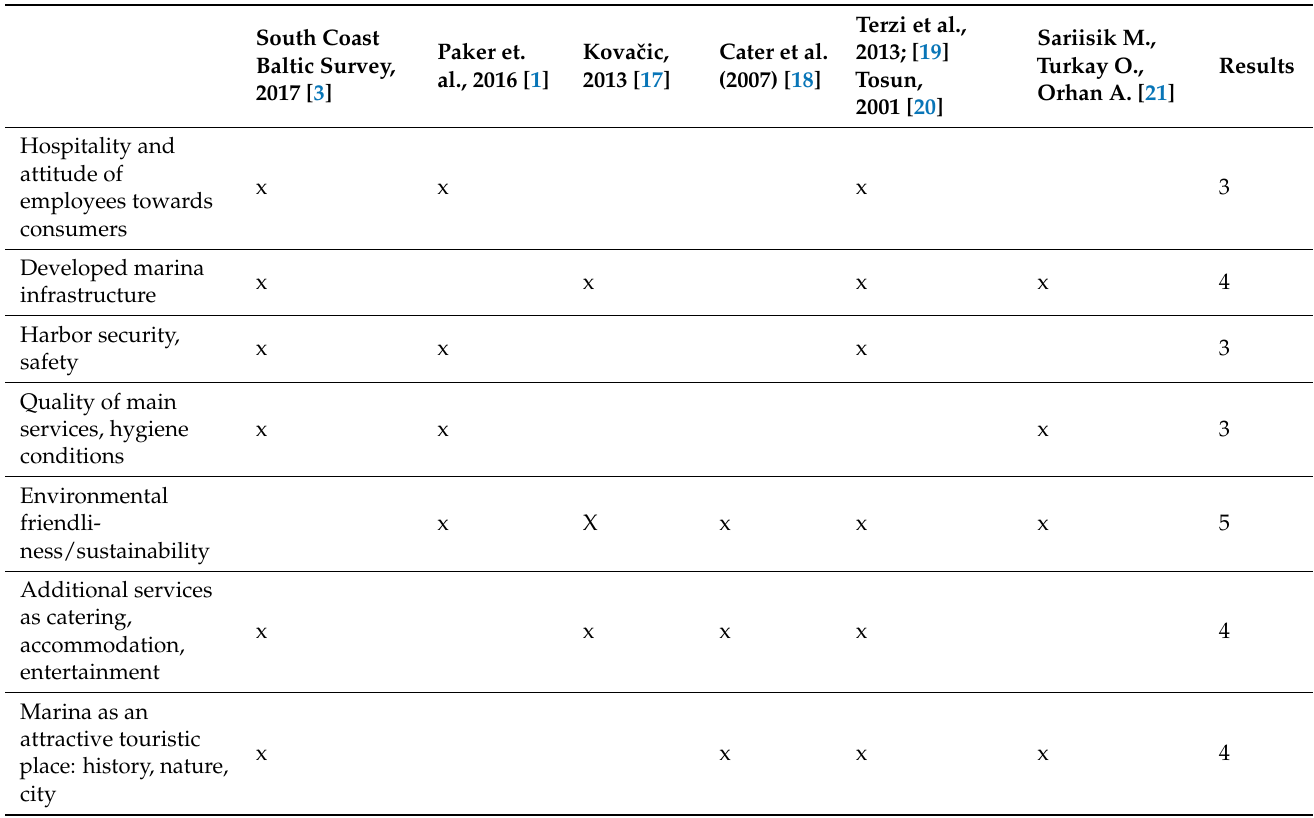
Table 1. Factors increasing marinas attractiveness for